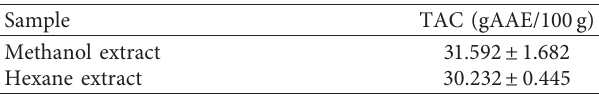
Table 5: Total antioxidant capacity of methanol and hexane ex- tracts expressed as gAAE/100